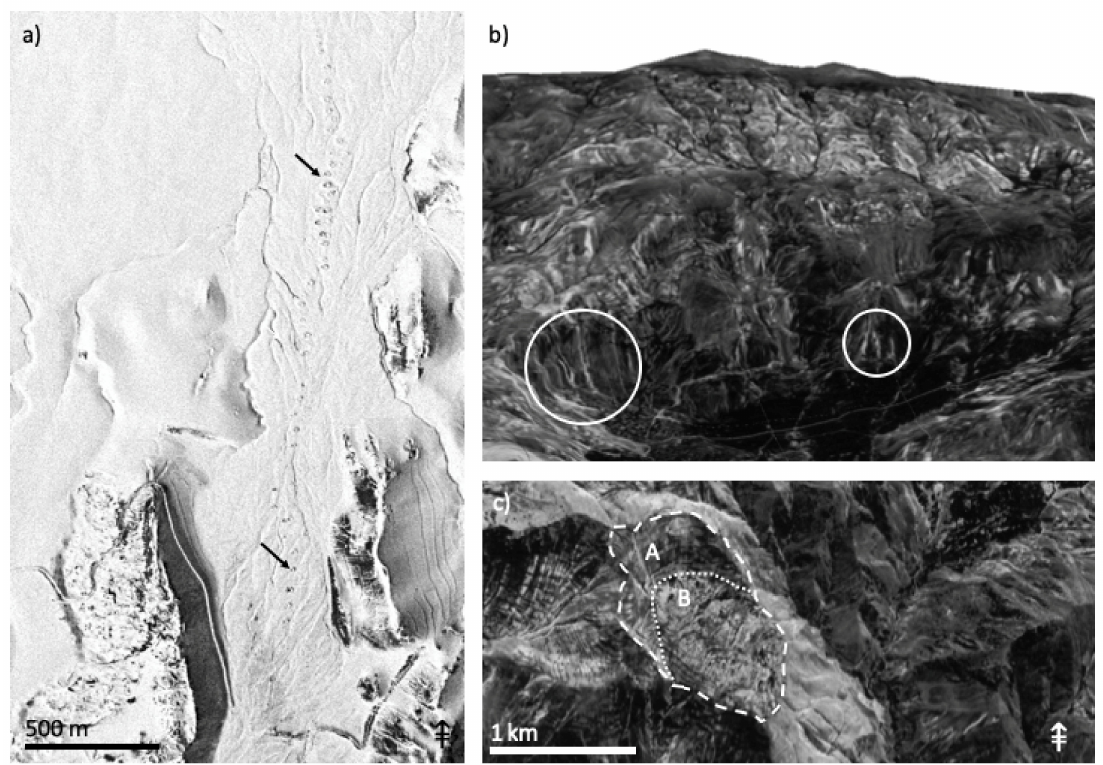
Figure 11. Feature identification eased by ( a ) snow cover helping to find water irrigation tunnel entry pits for maintenance in Tabriz, Iran (Data: KH-7 image from 5 Feb 1967, DZB00403600041H010001_a). Identification of narrow mudflows in Alborz mountains, Iran, eased by DEM overlay ( b ) on the top right image and of the ( c ) landslide scarp (A) and slump mass (B) on the lower right image (KH-4B from 31 May 1970,